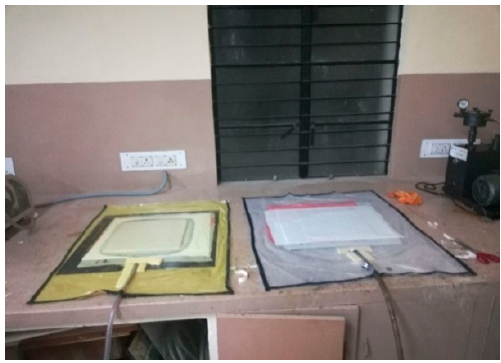
Figure 2. Composite fabrication.